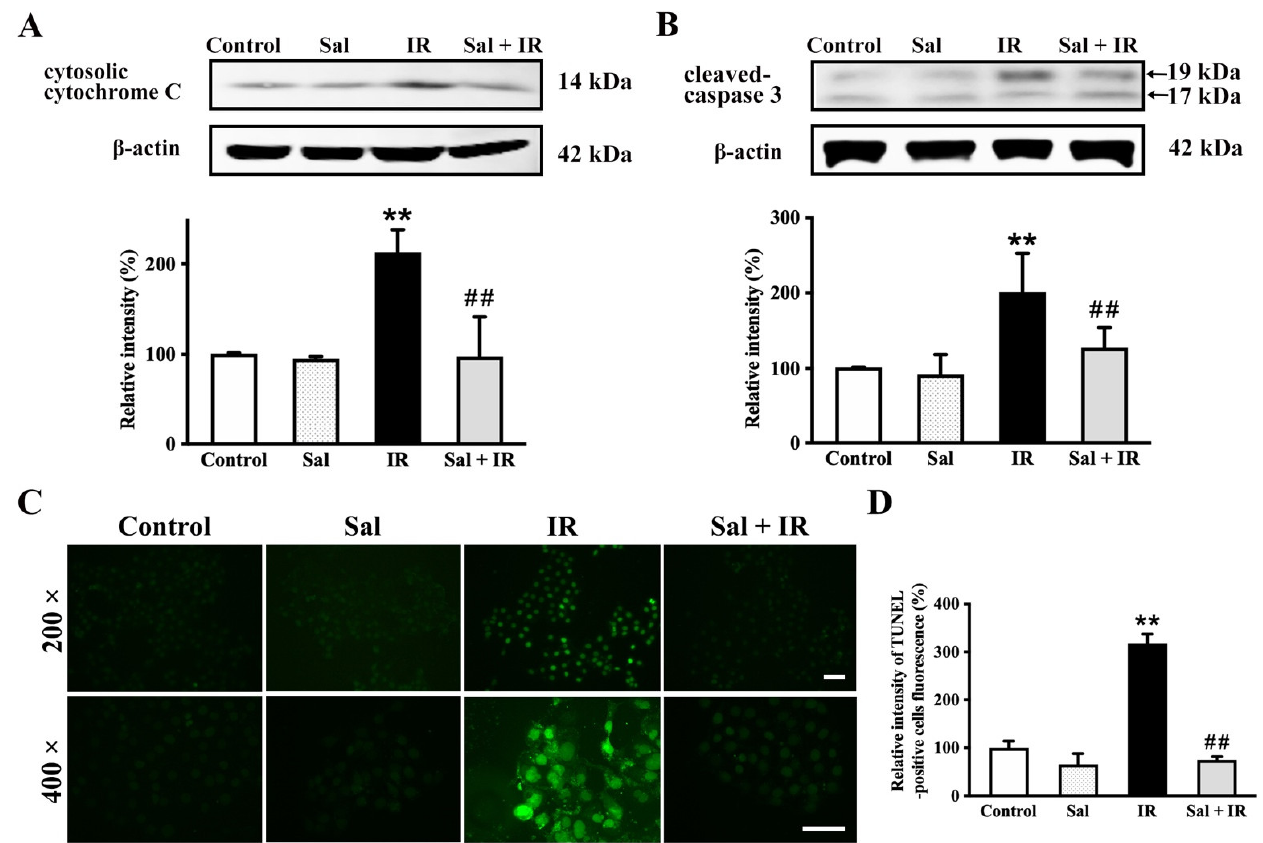
Figure 5. Salidroside inhibited cellular apoptosis by suppressing cytochrome c and cleaved-caspase 3 in irradiated SMG cells. SMG-C6 cells were treated as described above in Figure 3. ( A ) Release of cytochrome c and ( B ) cleaved caspase 3 were measured by Western blot. ( C ) Apoptosis was examined with a TUNEL assay. Nuclei of apoptotic cells were dyed with green fluorescence (bar = 100 μm). ( D ) Relative intensity of TUNEL-positive cell fluorescence. Data in ( A ), ( B ), and ( D ) are the mean ± SEM ( n = 3), with every data point assessed in triplicate. ** p < 0.01 vs. the controls. ## p < 0.01 vs. irradiation alone.